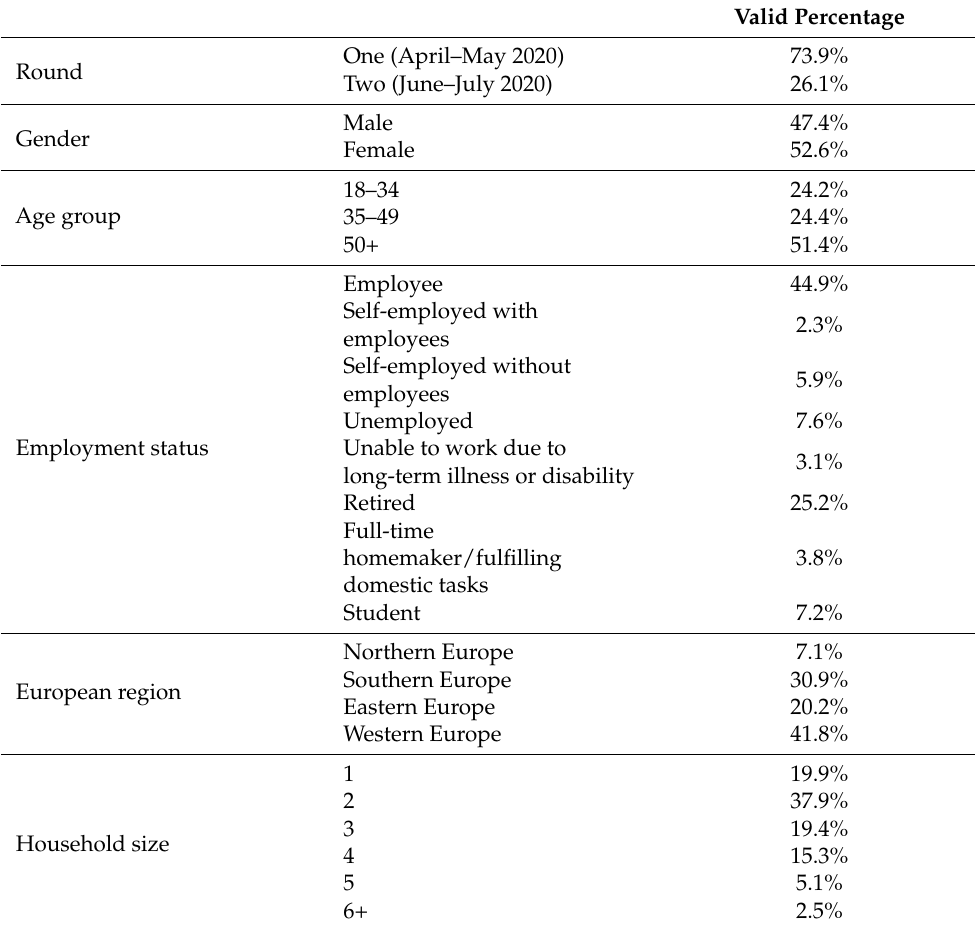
Table 1. Characteristics of the people who make up the study sample ( n =